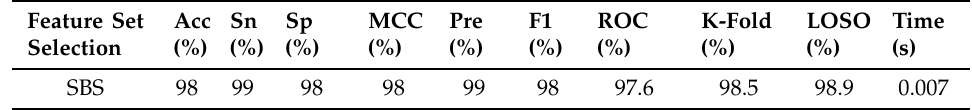
Table 7. Classification Performance with and without selected feature set by Wrapper based FS